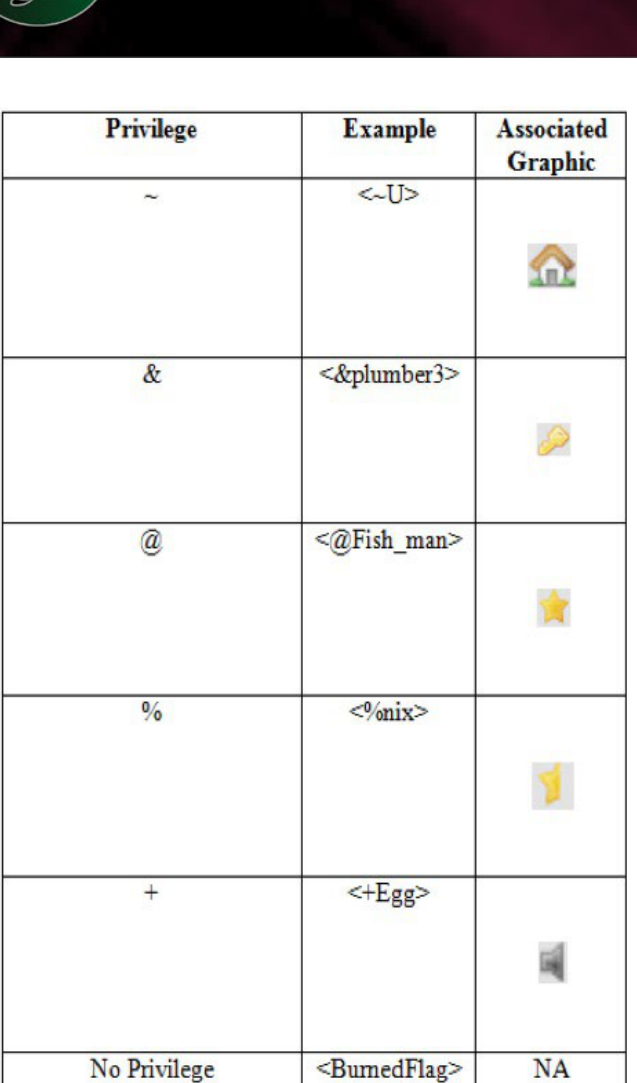
Figure 2: Privileges within the IRC